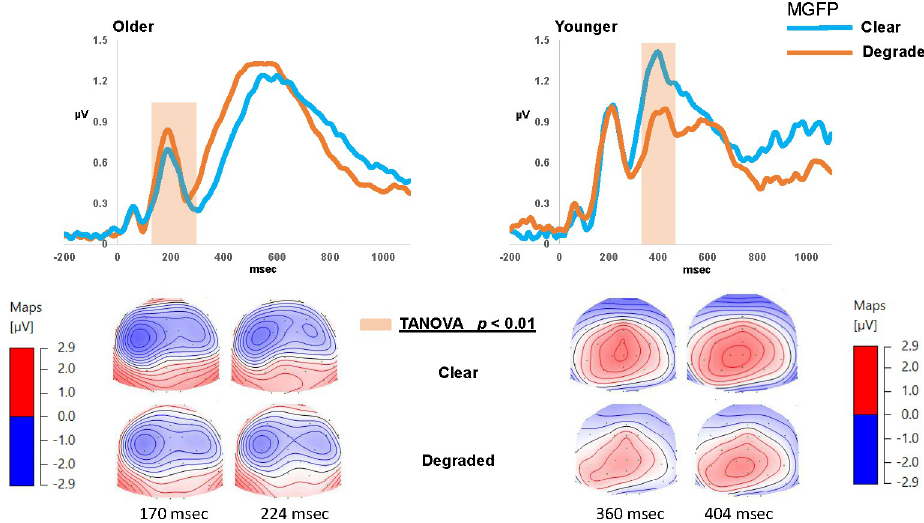
Fig 5. Topographical comparison of the non-target stimulus processing (epoch = 0–600 msec) for the older and younger participants: The top panel shows the grand-averaged mean global field power (MGFP) waveforms for the clear and degraded listening conditions in each group. Timeframes in the shaded region indicates periods of statistically significant differences ( p < 0.01) between listening conditions. The bottom panel shows the corresponding topographical maps that are linked to the shaded timeframes of the MGFP for each listening condition.